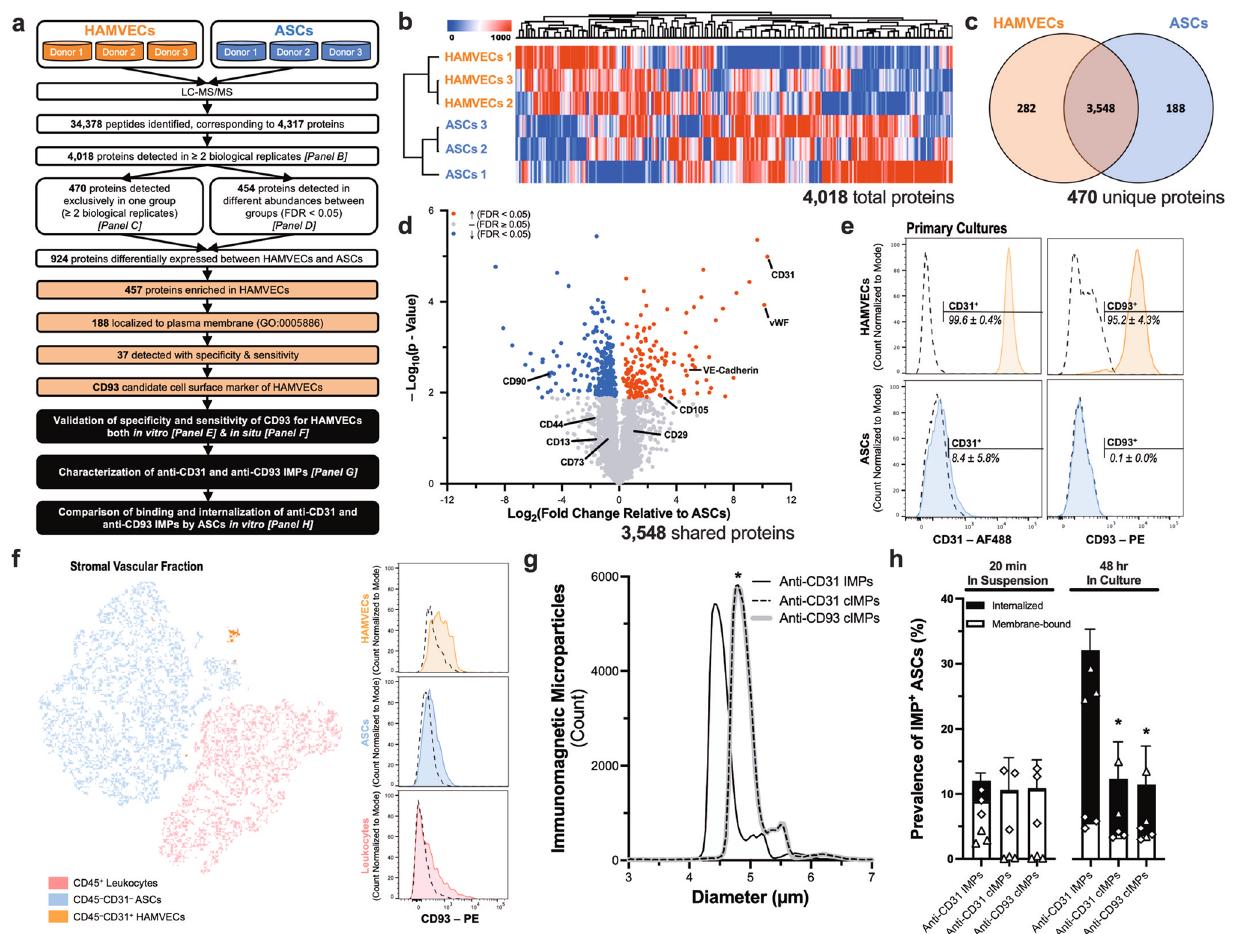
Fig. 7 Uptake of immunomagnetic microparticles (IMPs) by adipose tissue-derived stromal/stem cells (ASCs) is non-speci fi c, but size and exposure dependent. a Work fl ow depicting the proteomic comparison of human adipose tissue-derived microvascular endothelial cells (HAMVECs) and ASCs used to identify immunophenotypic markers with speci fi city for HAMVECs, which were then validated both in vitro and in situ before generating IMPs and evaluating their binding and internalization by ASCs. b Unsupervised hierarchical clustering of the global proteomes of HAMVECs and ASCs. c Distribution of proteins detected in HAMVECs and ASCs. d Relative abundances of proteins detected in both HAMVECs and ASCs. e Cell-surface expression of CD31 and CD93 by HAMVECs and ASCs in culture. Solid lines represent stained cells; dashed lines, isotype controls. f Speci fi city and sensitivity of CD93 for HAMVECs in the stromal vascular fraction of enzymatically digested human subcutaneous abdominal white adipose tissue. Presented is a t -distributed stochastic neighbour embedding (tSNE) plot depicting the unsupervised clustering of stromal vascular cells based on their cell-surface expression of CD45, CD31, and CD93, as well as histograms depicting the cell-surface expression of CD93 amongst the three principal subpopulations: CD45 − CD31 + HAMVECs, CD45 − CD31 − ASCs, and CD45 + leucocytes. Solid lines represent stained cells; and dashed lines, fl uorescence minus one controls. g Size distributions of IMPs. Commercial anti-CD31 IMPs were compared with cleavable (c)IMPs generated to be reactive against CD31 or CD93. * p < 0.05 compared with anti-CD31 IMPs. h Binding and internalization of IMPs by ASCs after 20 min in suspension (i.e. labelling conditions for magnet-assisted cell sorting procedure) and 48 hr in culture. Shown is a stacked bar graph depicting the total prevalence of ASCs exhibiting a membrane-bound and/or intracellular localization of the IMPs, and the corresponding proportions of each. Values represent mean ± standard deviation of the total prevalence. Triangles depict an internalized localization, and diamonds depict a membrane-bound localization.* p < 0.05 compared with anti-CD31 IMPs. e , h Values represent mean ± standard deviation. All experiments were performed in biological triplicate, using cells derived from three different donors ( n = 3 biologically independent